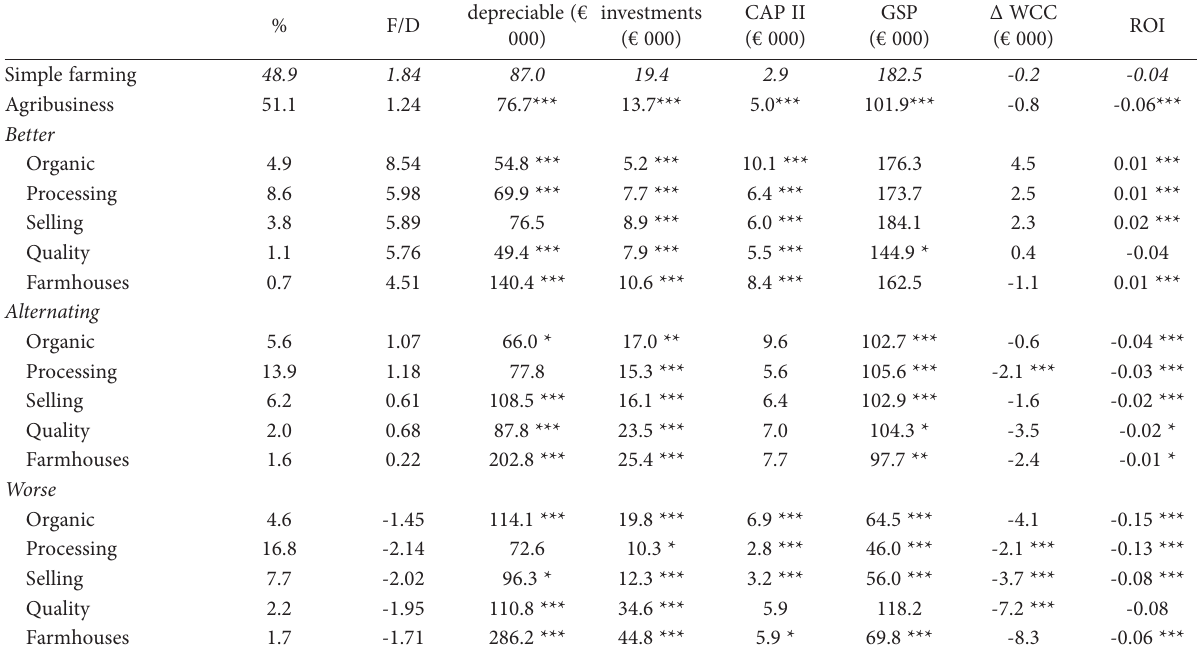
Table 6. Simple farming , total and single agribusinesses in the 3 financial result groups - percentage of farms on total sample, F/D index; per farm 000 € of depreciable, investments, CAP II aid, GSP, DWCC;